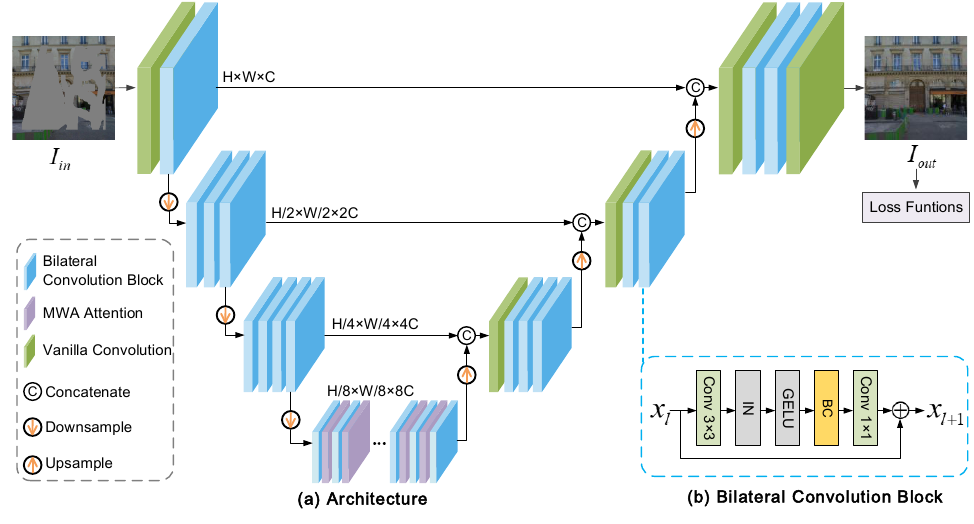
Figure 2. Overview of our inpainting